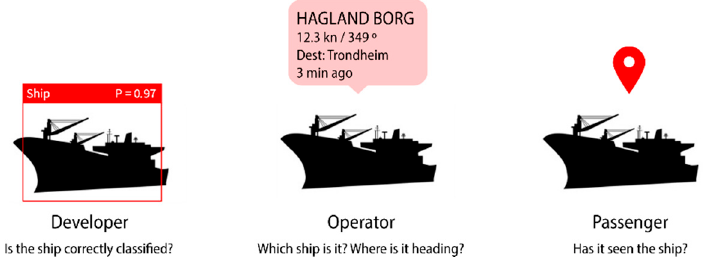
Figure 5. Different user groups have different XAI needs.